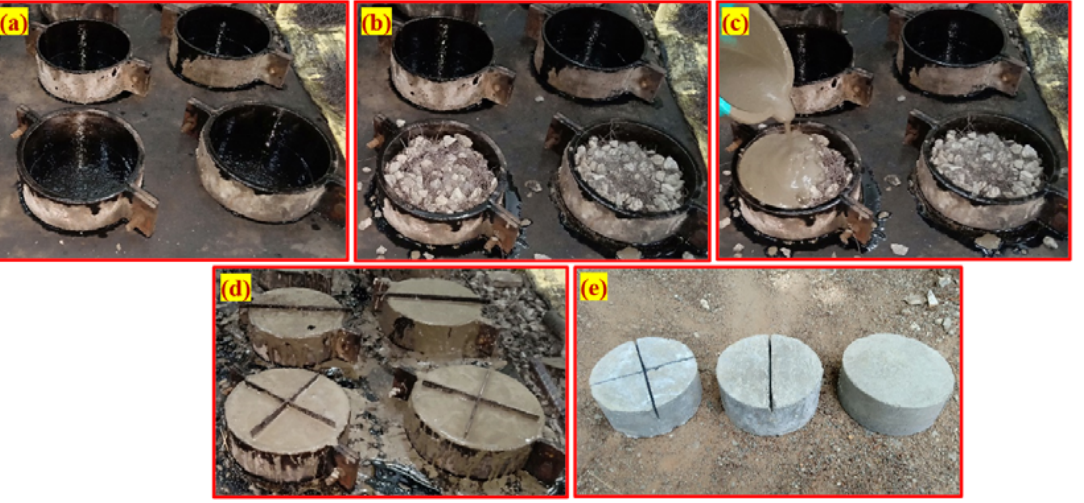
Figure 6. Fabrication technique: ( a ) empty mold, ( b ) filled fibers and aggregates into mold, ( c ) pouring of grout, ( d ) inserted notch plates into the specimens, and ( e ) specimens appearance after demolding.